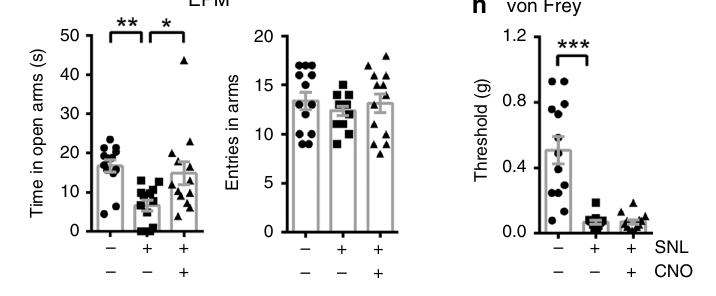
pPVT and con fi rmed the functionality of expressed ChR2 in brain slices by recording blue light-induced AP spikes in cells expressing ChR2-eYFP. Light stimulation induced strictly pulse- locked AP fi ring with high temporal fi delity (Fig. 4g). Subse- quently, AAV-CaMKII α -ChR2-eYFP and AAV-hSyn-DIO- mCherry were microinjected into the pPVT and vmPFC of nNOS-Cre mice, respectively (Fig. 4h). Three weeks later, mCherry + nNOS-expressing neurons in the vmPFC were